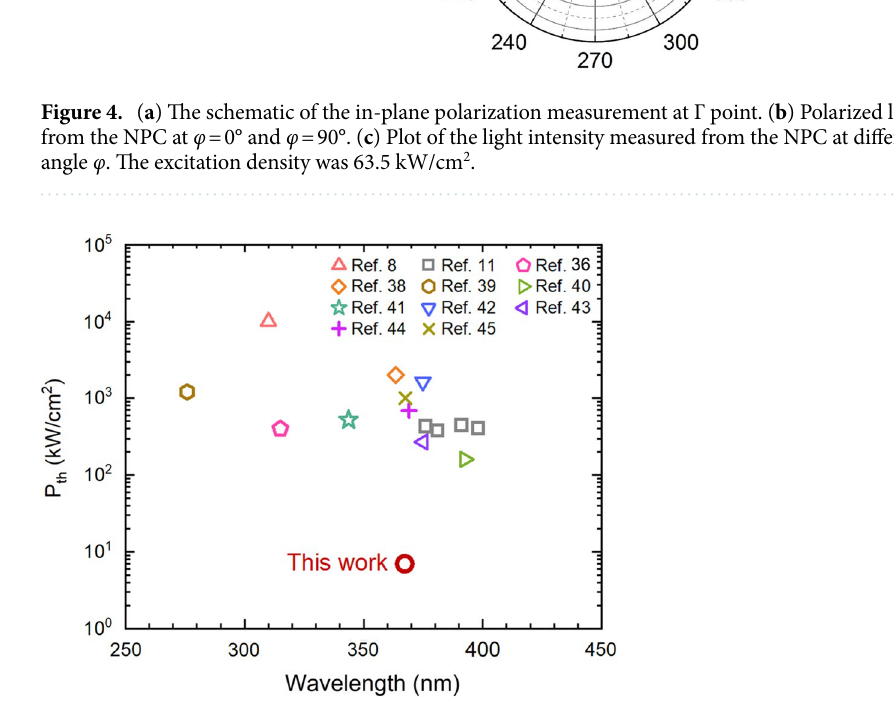
Figure 5. Comparison of the lasing threshold power density (P th ): the previously reported conventional AlGaN UV VCSELs versus the NPC UV SE lasers in this study. Dash line is a guide for